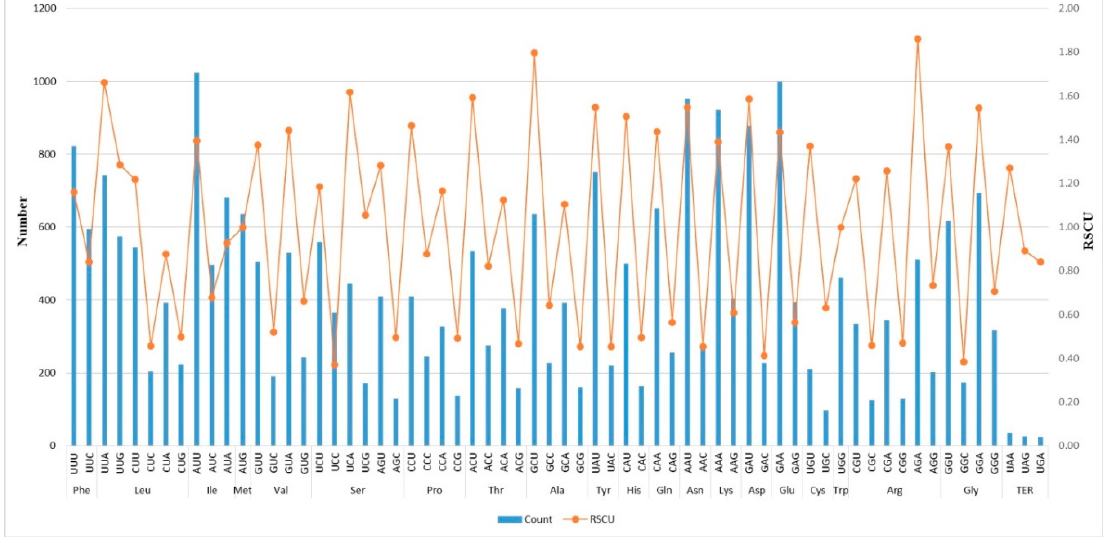
Figure 2. Details of codon preferences (bar) and relative synonymous codon usage values (line) of 12 chloroplast genomes of Nymphaeaceae.